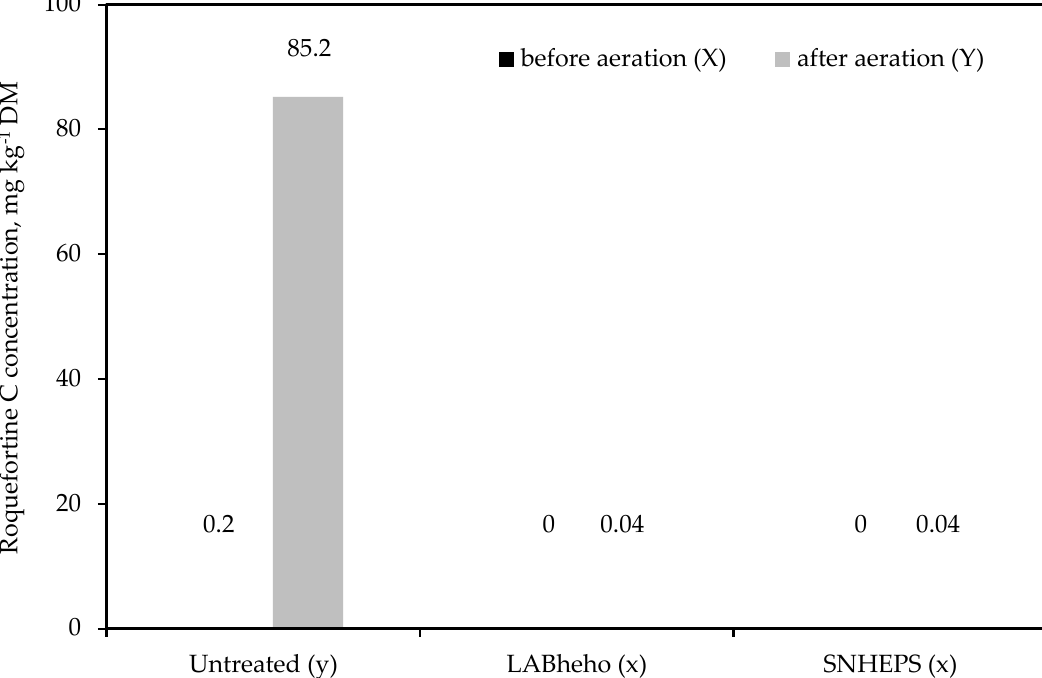
Figure 4. E ff ects of additive type on the concentration of the mycotoxin roquefortine C in early-cut rye silage stored for 64 days before (black bar) and after (grey bar) subsequent air exposure for 240 h. LAB heho , inoculant composed of L. buchneri CNCM-I 4323 and P. acidilactici DSM, total inoculation rate: 1.67 × 10 5 cfu g − 1 ; SNHEPS, liquid chemical additive containing sodium nitrite (195 g L − 1 ), hexamethylene tetramine (71 g L − 1 ) and potassium sorbate (106 g L − 1 ), 2 mL kg − 1 ; Unlike letters in brackets denote significance of e ff ect of aeration (X,Y, p < 0.001) and of e ff ect of additive (x,y, p < 0.001), aeration × additive interaction not significant, ANOVA-type statistics, SEM = 0-8.79, calculated separately for each treatment due to non-normality of data.